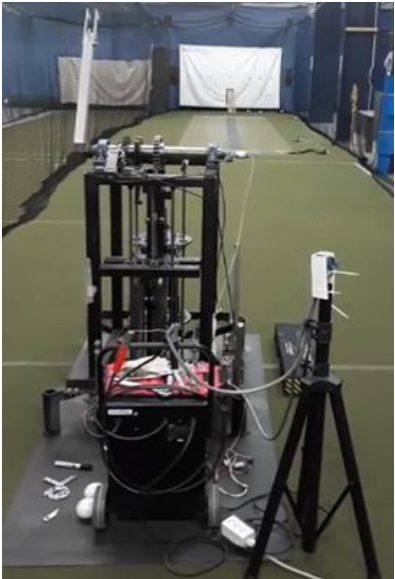
Figure 2. An Anthropometric Fast Bowling Machine